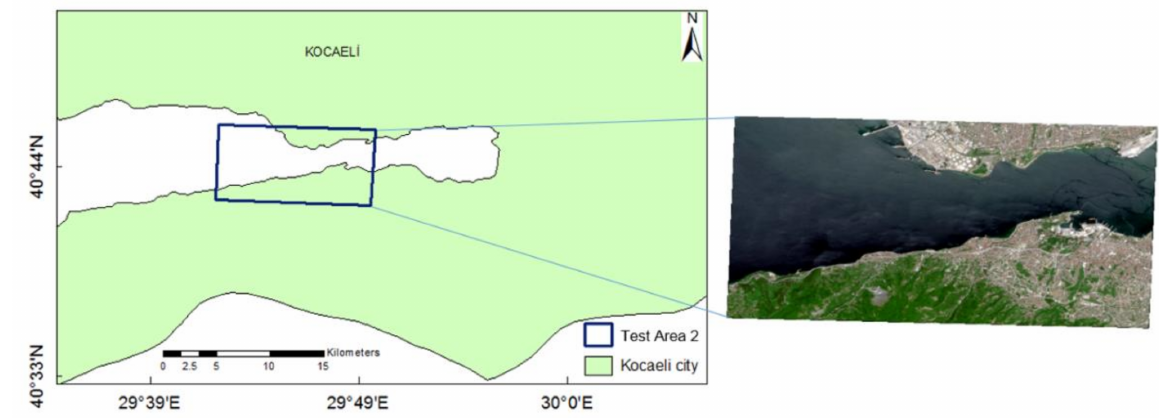
Figure 3. Selected test image of Sentinel-2A in Kocaeli city for the experiment.